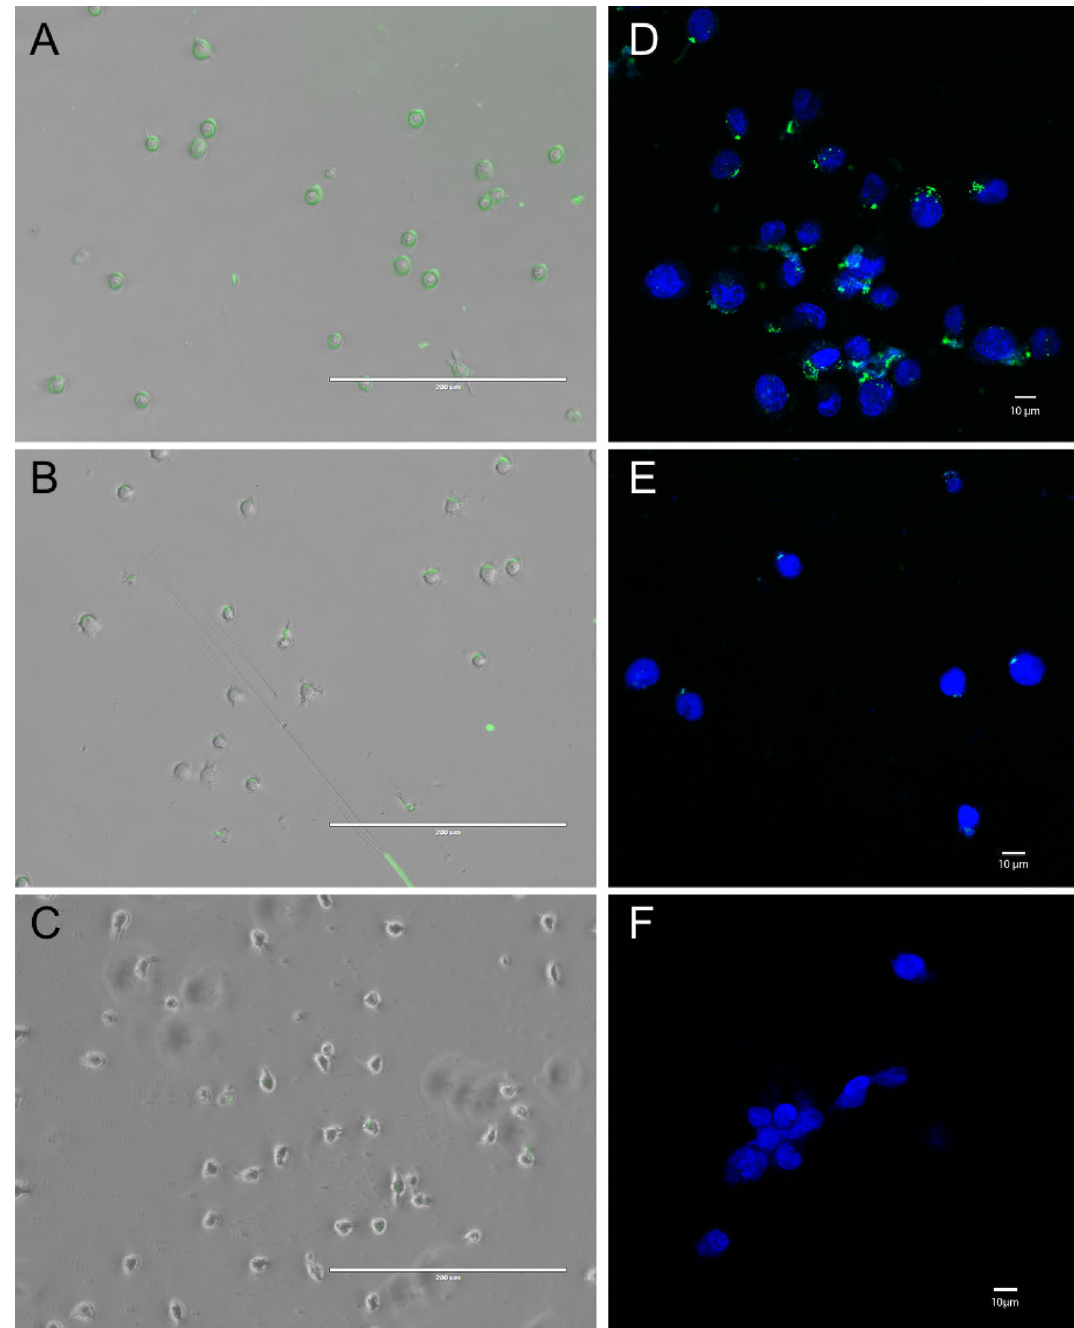
Figure 5. Localization of KGE02 to the cell membrane. ( A ) Overlay of brightfield and fluorescence microscopy images of 200 nM 6-FAM labelled KGE02 with MLL-AF9 cells. Clear localization of the fluorescence can be seen surrounding the cells. ( B ) Overlay of brightfield and fluorescence microscopy images of 200 nM 6-FAM labelled KGE02 with MLL-AF9 cells after DNA nuclease treatment. Most of the fluorescence signal has been lost after nuclease treatment, suggesting membrane localization of the aptamer’s target. ( C ) Overlay of brightfield and fluorescence microscopy images of 200 nM 6-FAM labelled scrambled sequence with MLL-AF9 cells. Minimal non-specific fluorescence can be detected. ( D ) Confocal microscopy image of 200 nM 6-FAM labelled KGE02 with MLL-AF9 cells stained with DAPI. Punctate localization of the fluorescence can be seen surrounding the cells. ( E ) Confocal microscopy images of 200 nM 6-FAM labelled KGE02 with AML-AF9 cells after DNA nuclease treatment. Most of the fluorescence signal has been lost after nuclease treatment, with minimal internalized fluorescence observed. ( F ) Confocal image of 200 nM 6-FAM labelled scrambled sequence with MLL-AF9 cells. No non-specific fluorescence can be